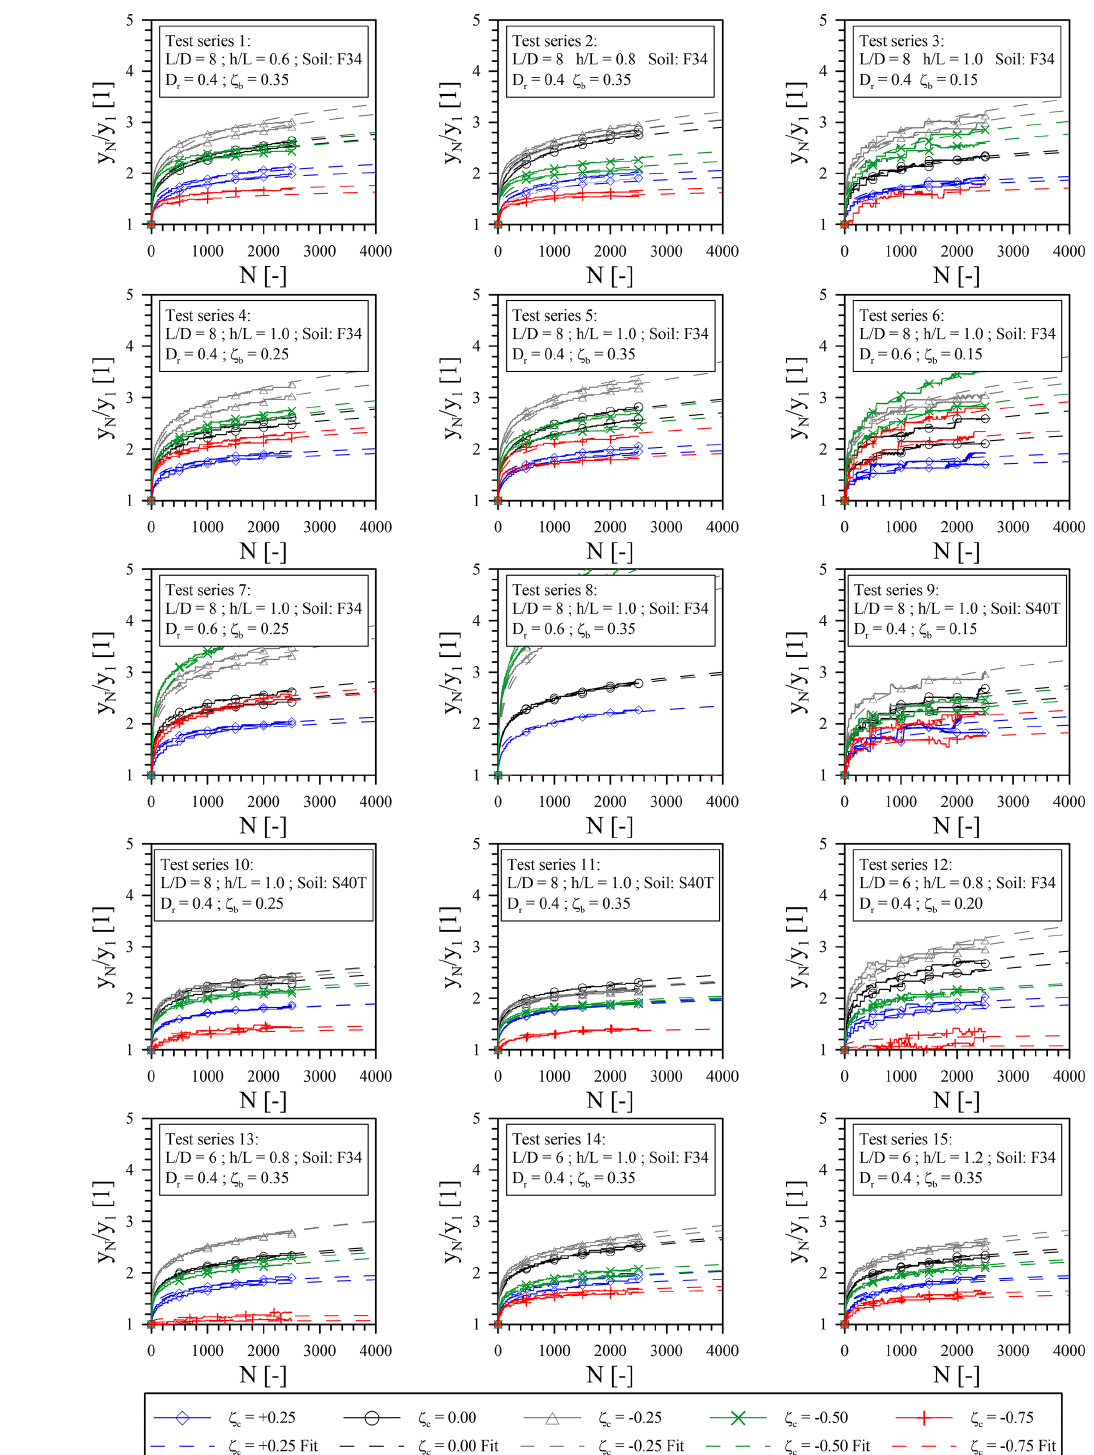
Figure 6. Cyclic test results: normalized pile head displacement ( y N /y 1 ) against load cycle number ( N ) for all 15 test series.